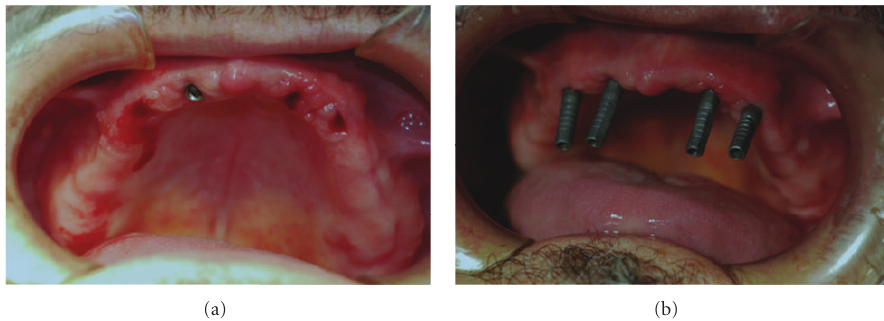
Figure 1: (a) Patient just after the four maxillary implants inserted. (b) Abutments screwed to the implants.